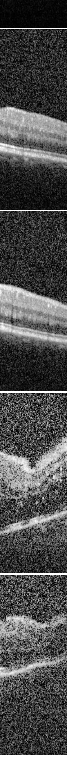
Figure 3. Sample of different grades and their segmentation results. First column (up–to–down) represents the grades 0, 0.5, 1, 2 and 3. The second column represents the corresponding segmentation results,